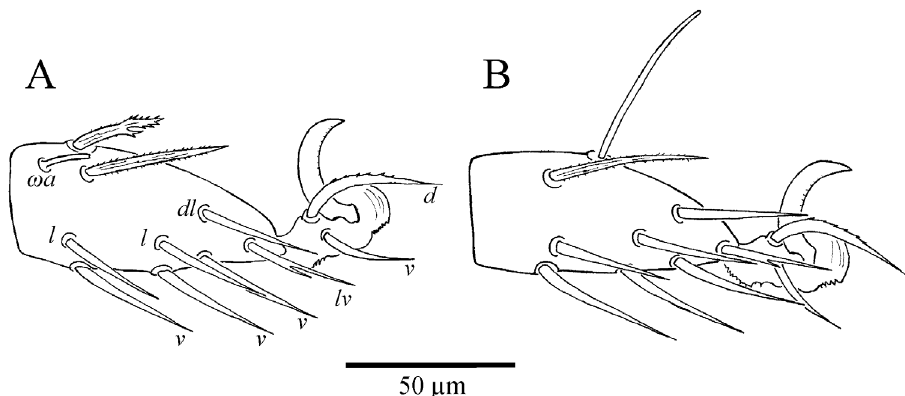
Figure 8. Neocarus spelaion sp. n.: Acrotarsus II, female; A posterolateral view B anterolateral view. Ab- breviations; ω a = solenidia, d = dorsal setae, l = lateral setae, dl = dorsolateral setae, v = ventral setae, lv =lateroventral